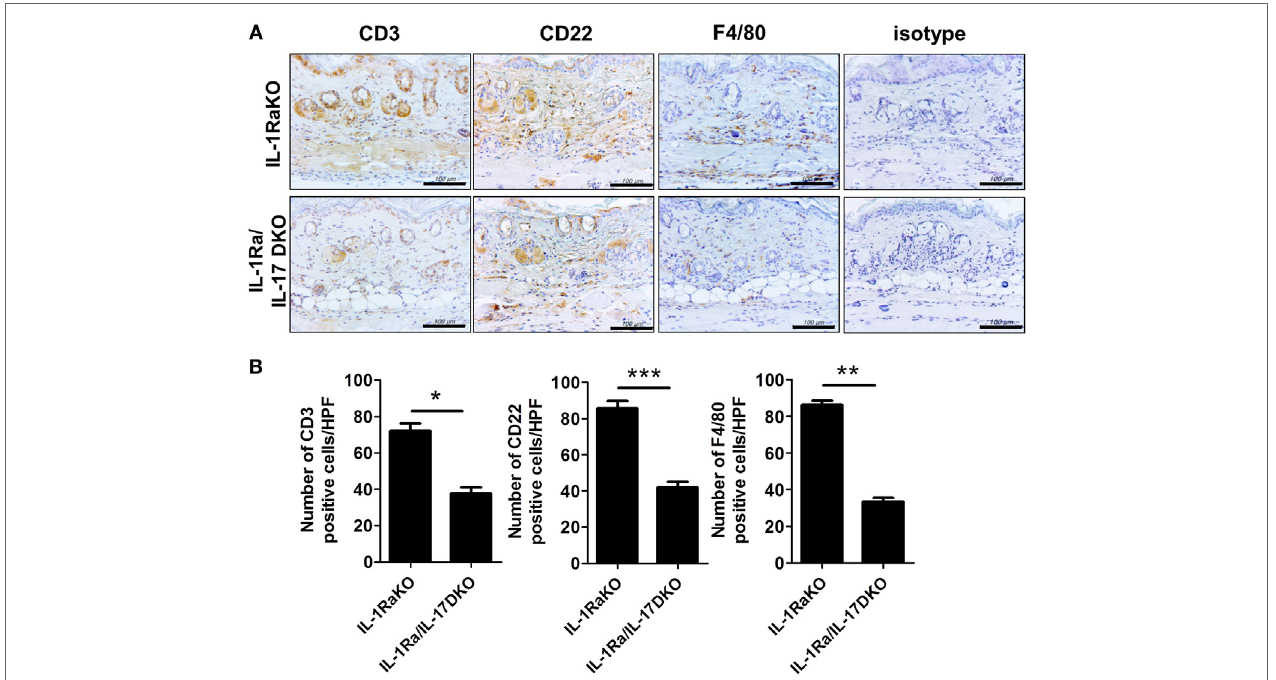
FigUre 4 | Inflammatory cell infiltration into lesional skin. (a) Representative sections of lesional skin stained for CD3, CD22, and F4/80 by immunohistochemistry. Scale bar represents 100 µm. (B) The number of infiltrating T cells (CD3 + ), B cells (CD22 + ), and macrophages (F4/80 + ) per HPF are shown in bar graphs as the mean ± SEM for three independent experiments per group. * p < 0.05, ** p < 0.01, *** p <